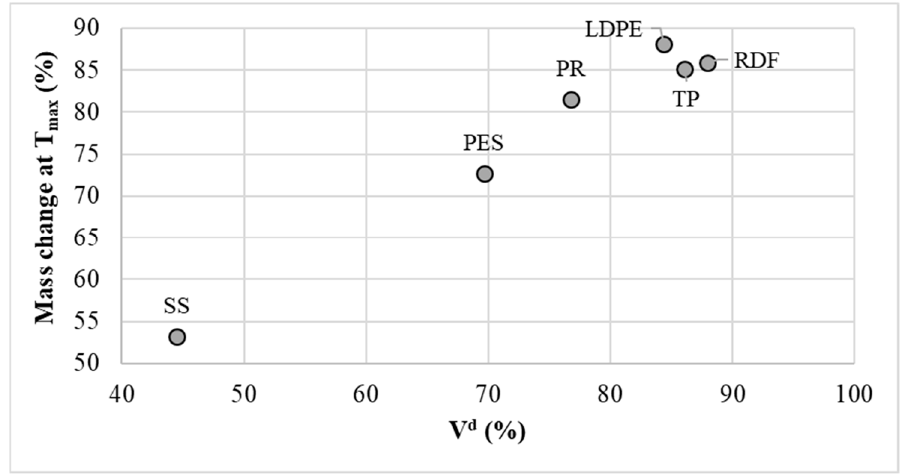
Figure 5. Mass change at T max (%) from TGA and volatile matter V d (%).